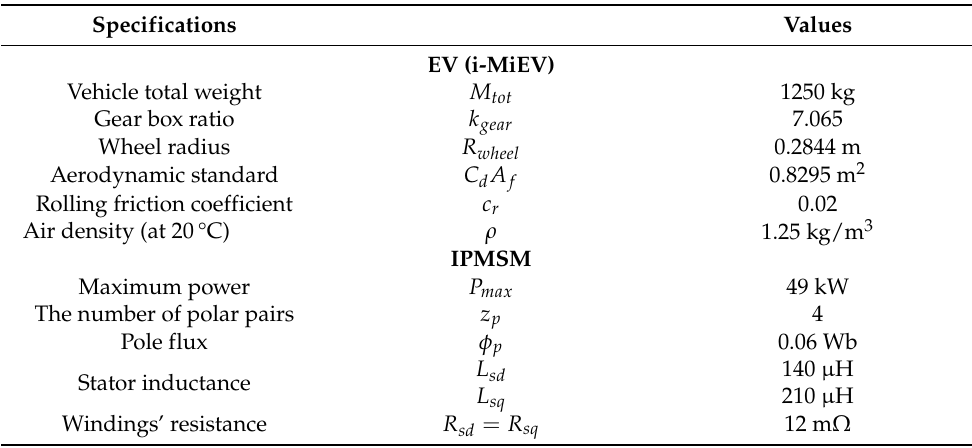
Figure 9. Experimental supercapacitor NESSCAP EMHSR-0062C0-125R0SR2. Table 2. System